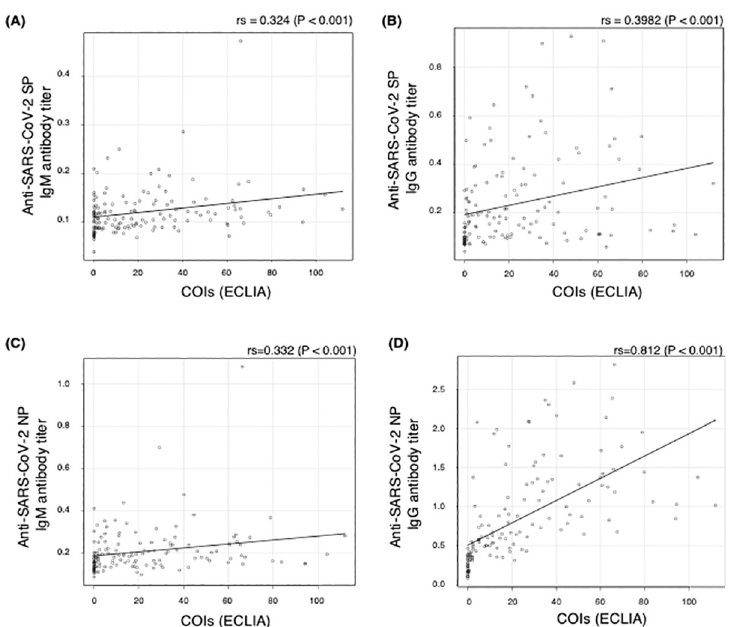
Fig 5. Correlation between anti-SARS-CoV-2 antibody titers in ELISA and COI in ECLIA. The correlation between SARS-CoV-2 antibody titers in ELISA and cutoff indexes (COIs) in ECLIA in blood samples collected from 143 cruise ship crew members who had positive first SARS-CoV-2 genetic test results were evaluated using Spearman’s rank- order correlation. SP, spike protein; NP, nucleocapsid protein; ELISA, enzyme-linked immunosorbent assay; ECLIA, electrochemiluminescence